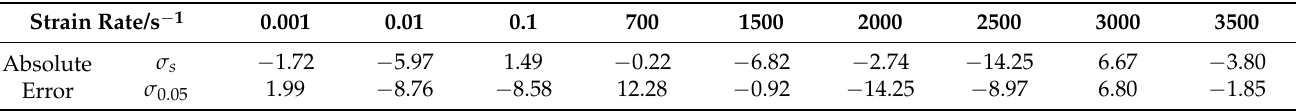
Table 3. Absolute errors of yield strength and flow stress in both loading directions for the same strain